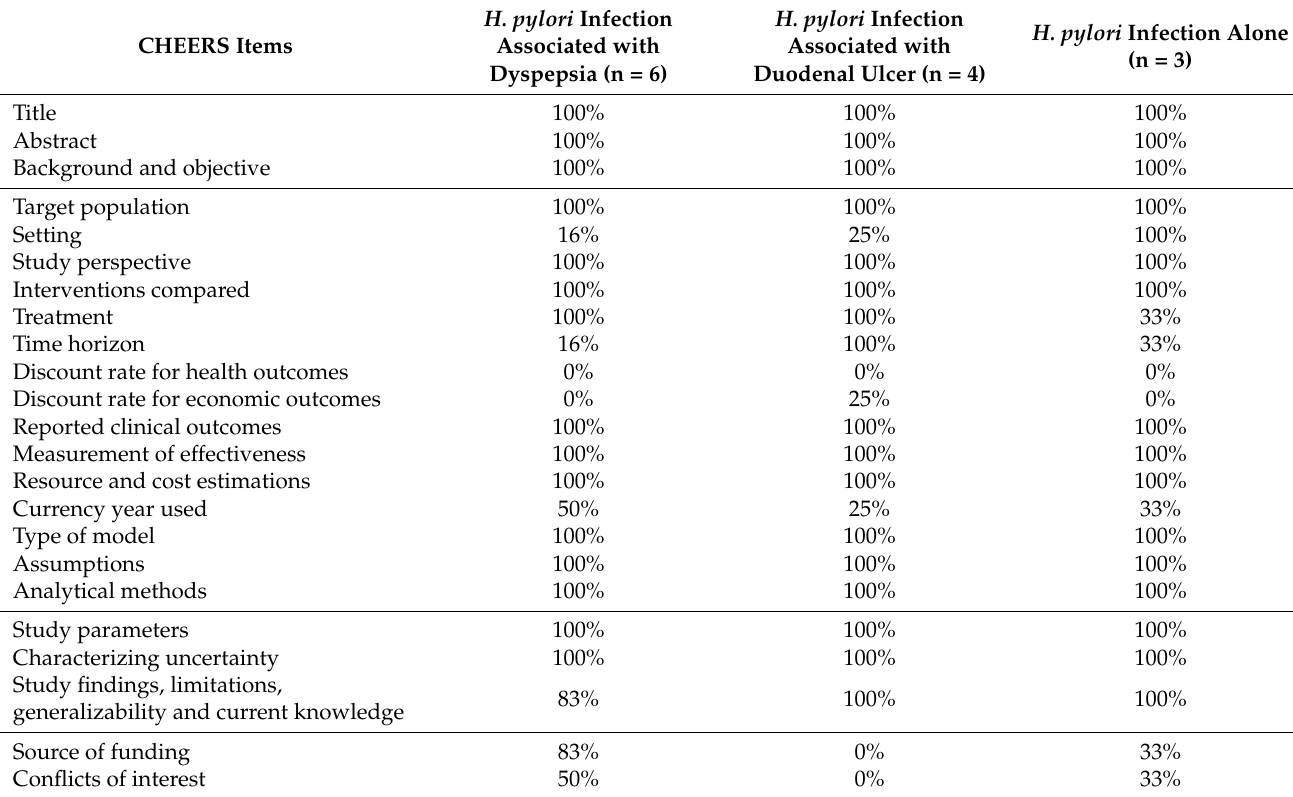
Table 1. CHEERS checklist results (percentage of articles that included the